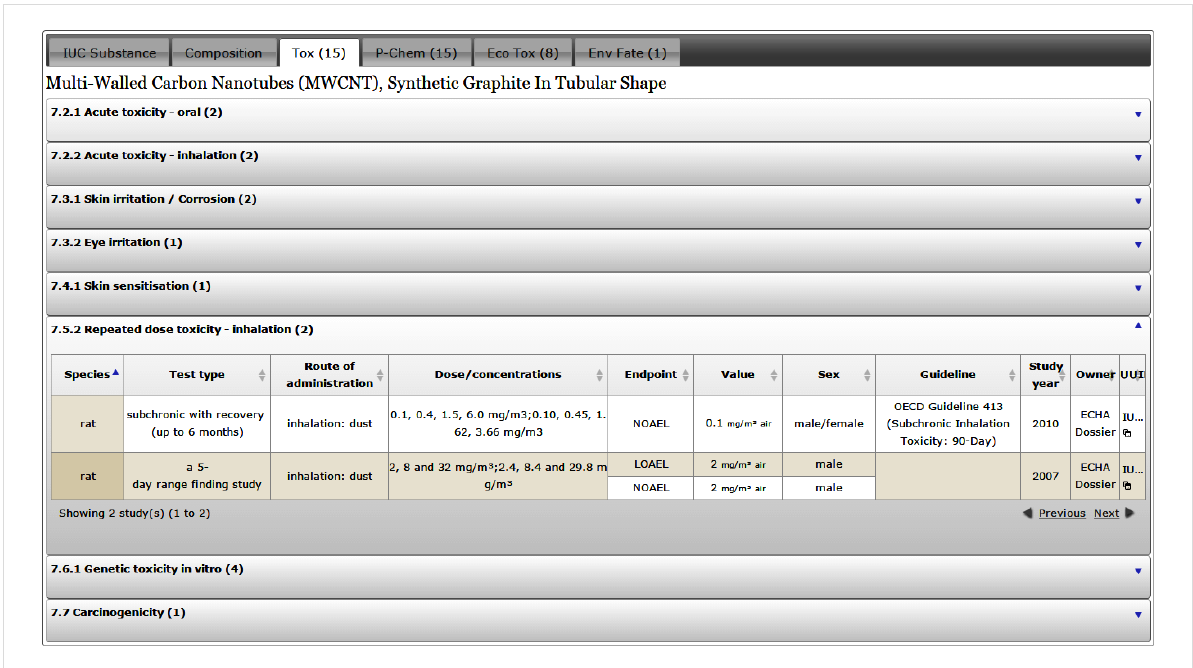
Figure 12: Toxicity data for multi-walled carbon nanotubes. The repeated dose toxicity (inhalation) is shown in the expanded row, illustrating support for multiple endpoints (LOAEL, NOAEL) and test types.